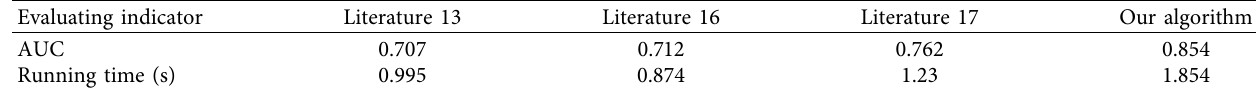
Table 2: Algorithm performance comparison table.